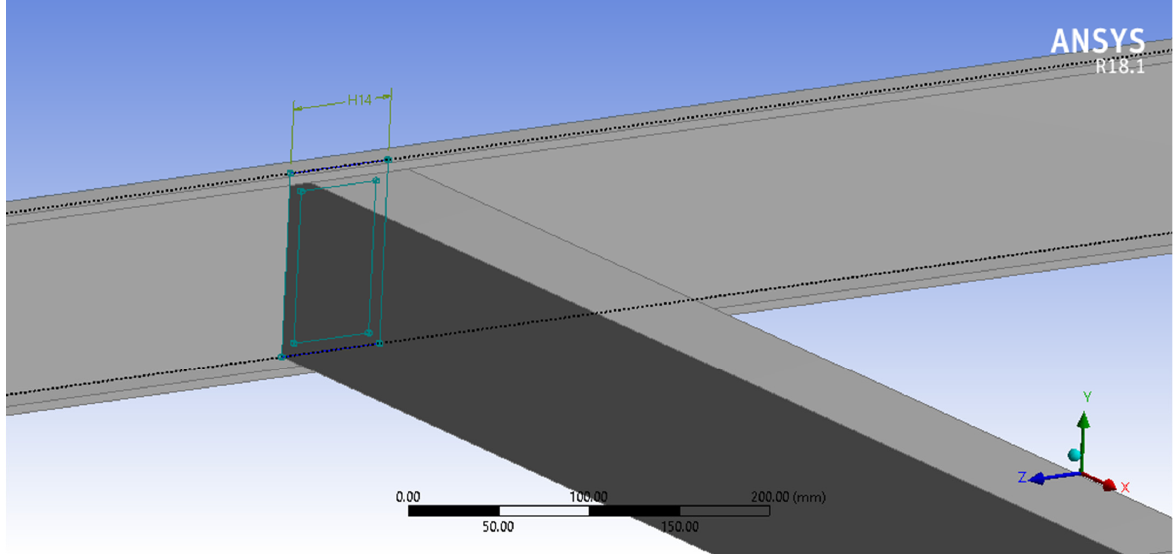
Figure 11. H14 dimension (cross member width) selected for optimization.